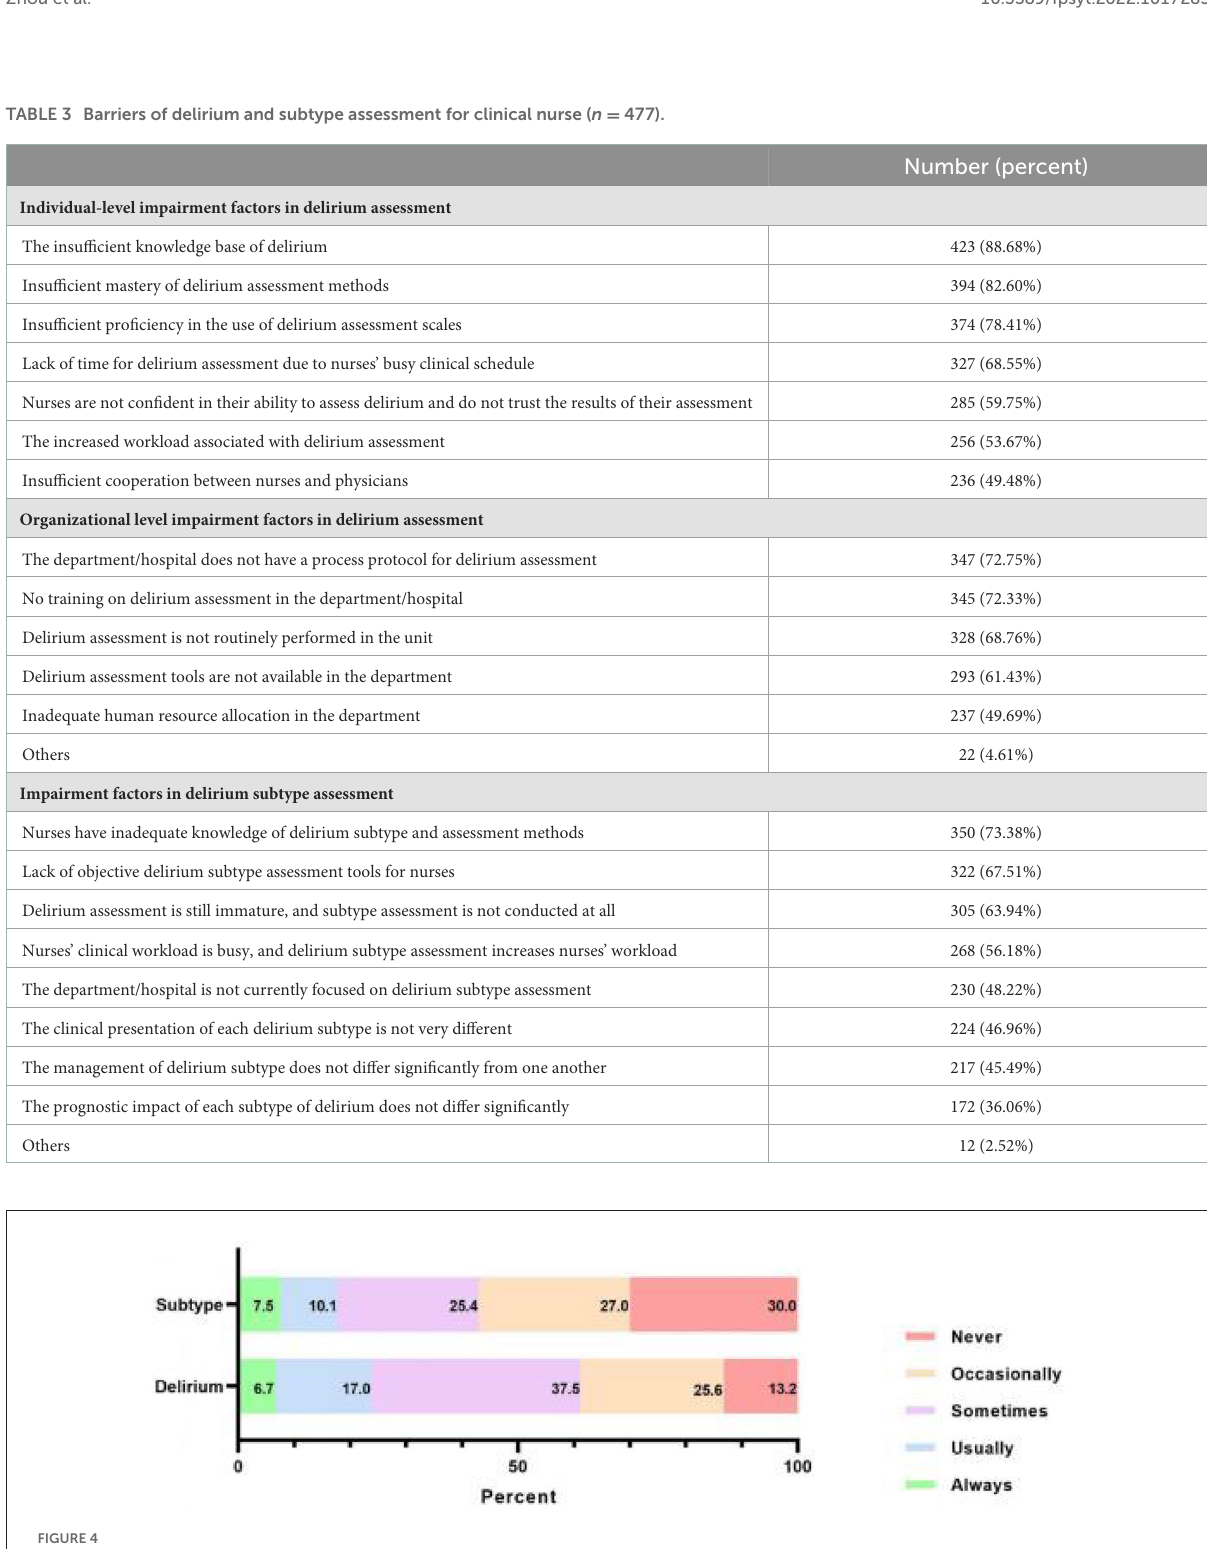
FIGURE4 Practice score of delirium and subtype assessment for clinical nurses ( n =